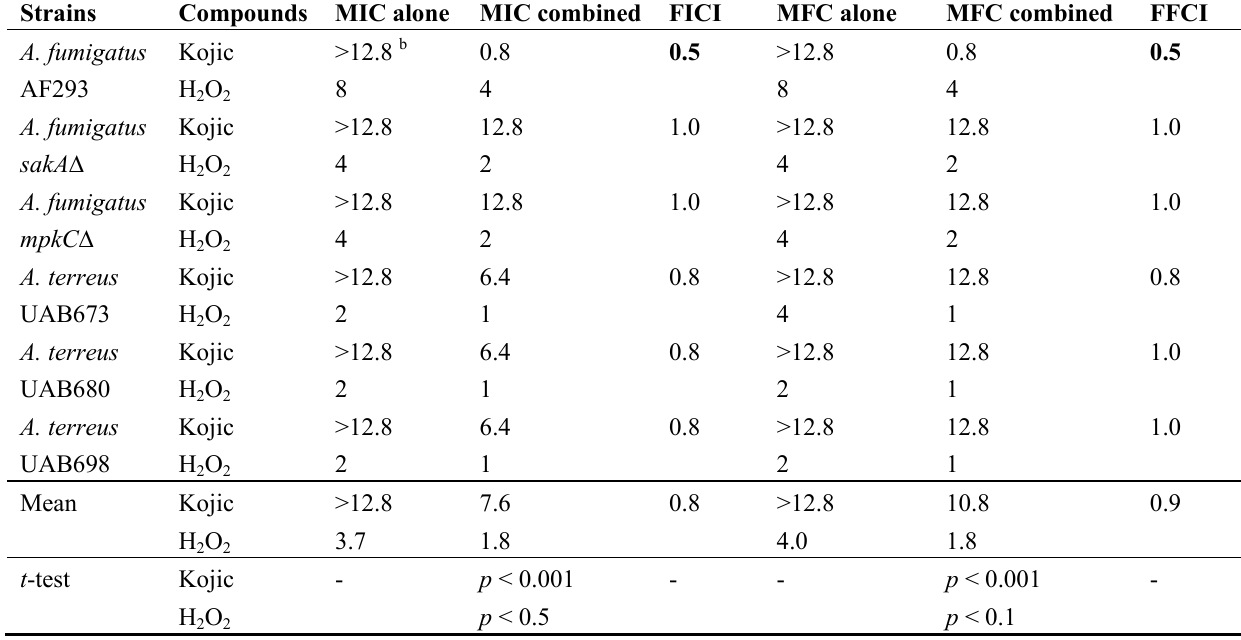
Table 2. Antifungal chemosensitization of kojic acid (mM) with H Aspergillus strains. a Minimum fungicidal concentrations (MFCs) are concentrations where ≥ 99.9% fungal death was